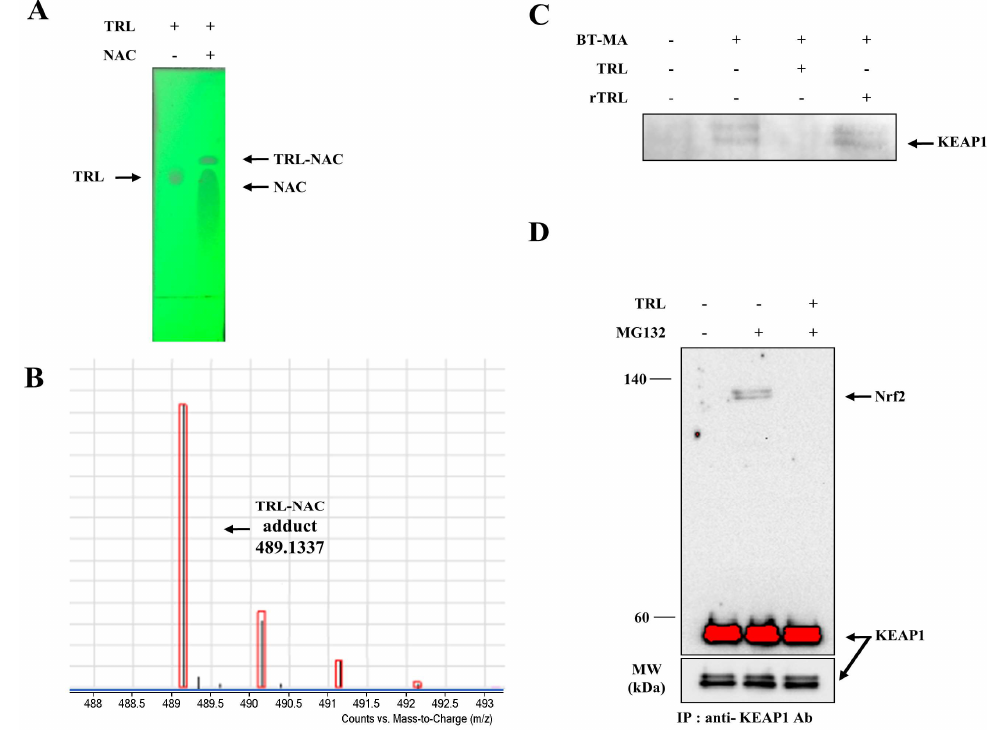
Figure 3. TRL reacts with a thiol group in KEAP1 to activate Nrf2. ( A ) TRL (200 µ M) in acetoni- trile/PBS (1/1, v / v ) was incubated with or without 20 mM N-acetylcysteine (NAC) for 10 m. The reaction mixtures were analyzed by thin-layer chromatography. ( B ) The reaction mixture was sub- jected to mass spectrometry. The molecular weight peak ( m / z , in negative mode) corresponding to the NAC-TRL adducts was detected. ( C ) Cell lysates were treated with 100 µ M of either TRL or rTRL for 30 m, followed by incubation with a thiol-reactive biotin BT-MA (1 µ M) at 30 ◦ C for 2 h. The beads were washed five times. Laemmli sample buffer was added, and the mixture was boiled for 5 m prior to western blot analysis. The blots were probed with an anti-KEAP1 antibody. ( D ) HCT116 cells were pretreated with MG132 (10 µ M) for 2 h and then lysed with lysis buffer. The cell lysates were treated with TRL (100 µ M) at 30 ◦ C for 2 h, followed by the addition of anti-KEAP1 antibody at 4 ◦ C for 2 h. Protein A/G agarose beads were added to the lysates at 4 ◦ C for 2 h. The beads were washed five times. Laemmli sample buffer was added, and the mixture was boiled for 5 min. Nrf2 and KEAP1 proteins in the immunocomplex were monitored by western blotting. NM, not measurable.